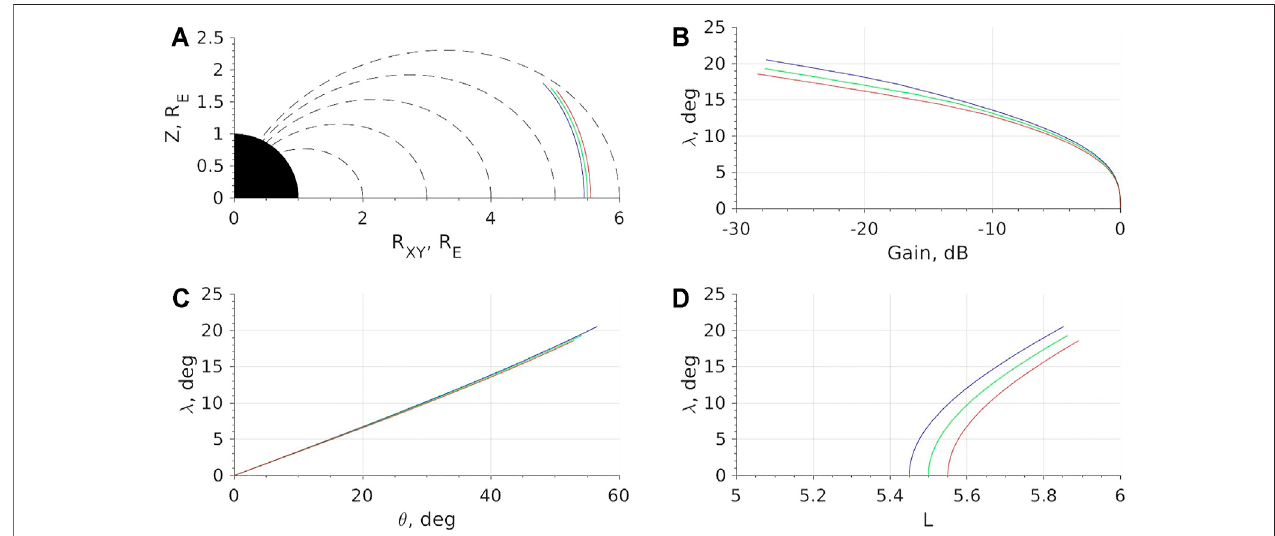
FIGURE 4 | Examples of ray tracing simulation for rays with 700 Hz. (A) ray paths of rays launched at the equator with initial L (cid:1) 4.45 (blue), 5.5 (green) and 5.55 (red). (B) wave gain, (C) wave normal angle and (D) L-shell as a function of magnetic latitude λ .